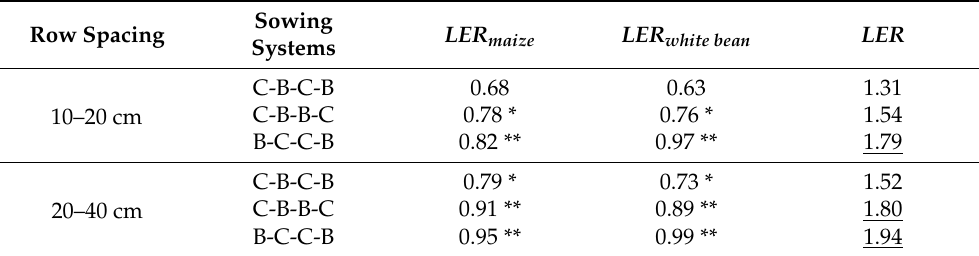
Table 7. Land equivalent ratio ( LER ) of the maize-white bean sowing systems and the partial LER ( LER maize and LER white bean ) as affected by row spacing at Nur Sultan, Kazakhstan research station. Sowing LER maize LER white bean LER Row Spacing Systems C-B-C-B 0.68 0.63 1.31 C-B-B-C 0.78 * 0.76 * 1.54 10–20 cm B-C-C-B 0.82 ** 0.97 ** 1.79 C-B-C-B 0.79 * 0.73 * 1.52 C-B-B-C 0.91 ** 0.89 ** 1.80 20–40 cm B-C-C-B 0.95 ** 0.99 **